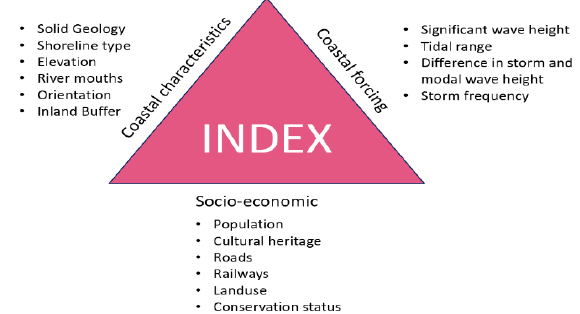
Figure 1. Variable classification for indices (modified